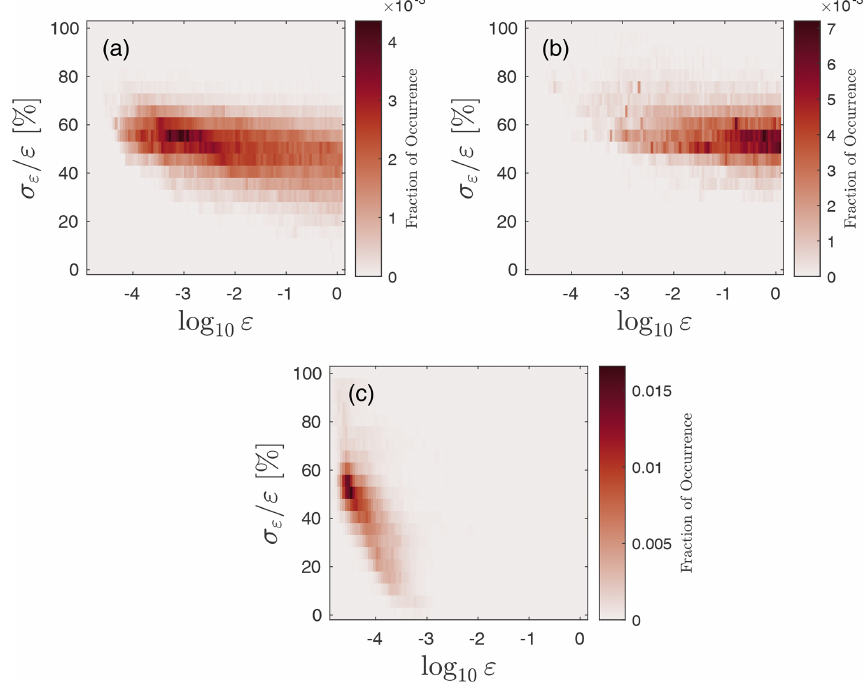
Figure 10. Fraction of occurrence of each uncertainty estimation and turbulence dissipation rate combination for the WC49 (a) , WC68 (b) , and Halo (c)